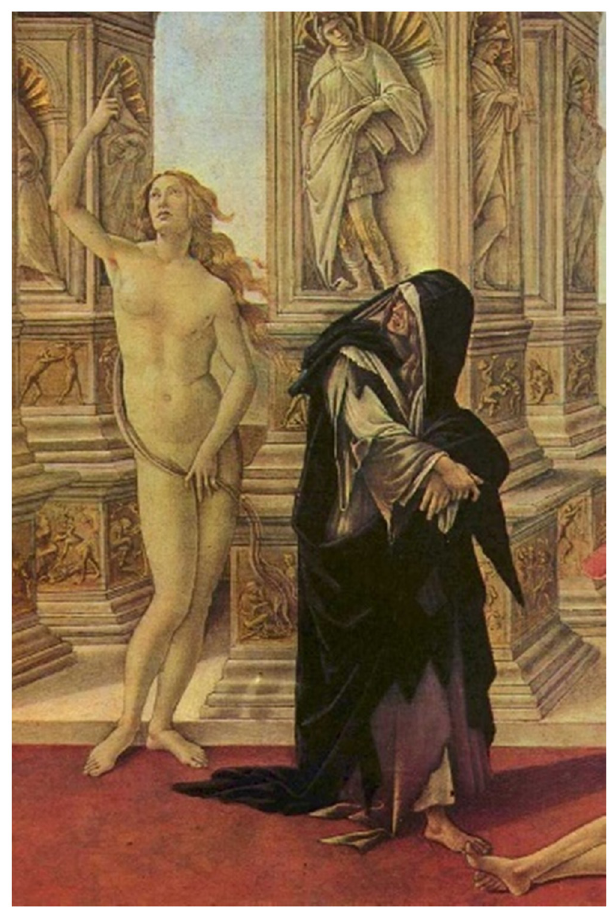
Figure 11: Botticelli, Calunnia .